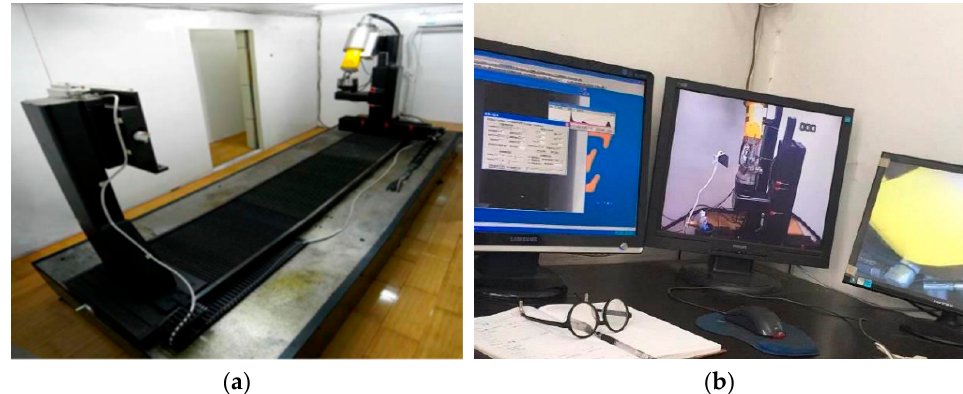
Figure 3. CT Test System. ( a ) CT scanner; ( b ) Data acquisition and processing system.